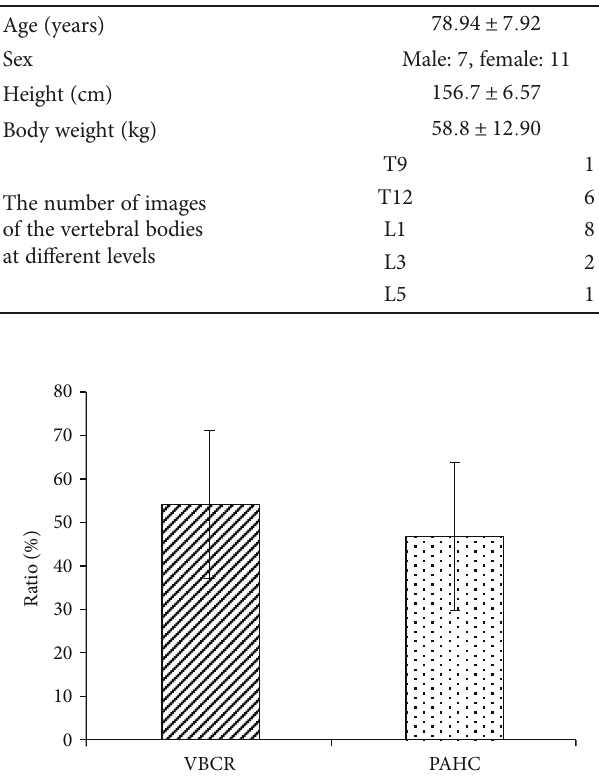
Figure 3: Lateral plain radiograph of the thoracolumbar spine. The arrows point to the crescent-shaped shadow in the vertebral body, that is, the IVC.